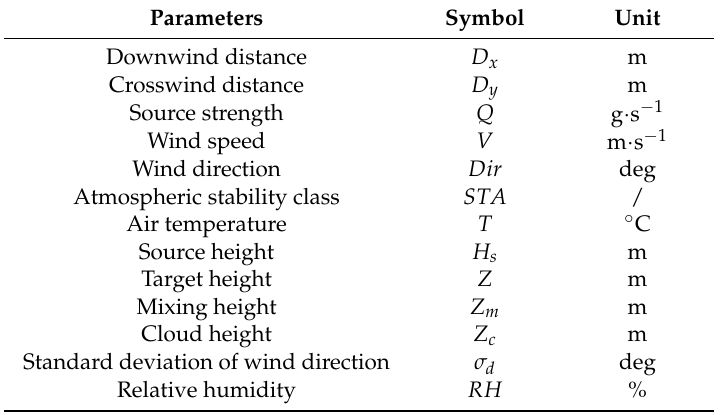
Table 1. Common original monitoring parameters in the Prairie Grass data